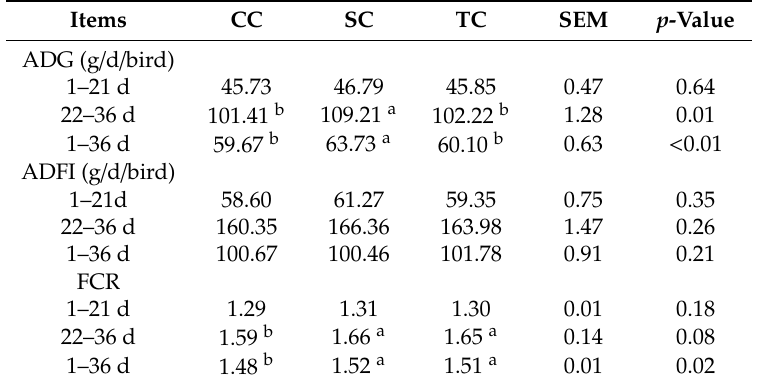
Table 3. Effects of fermented soybean meal (FSBM) on the growth performance of broilers.